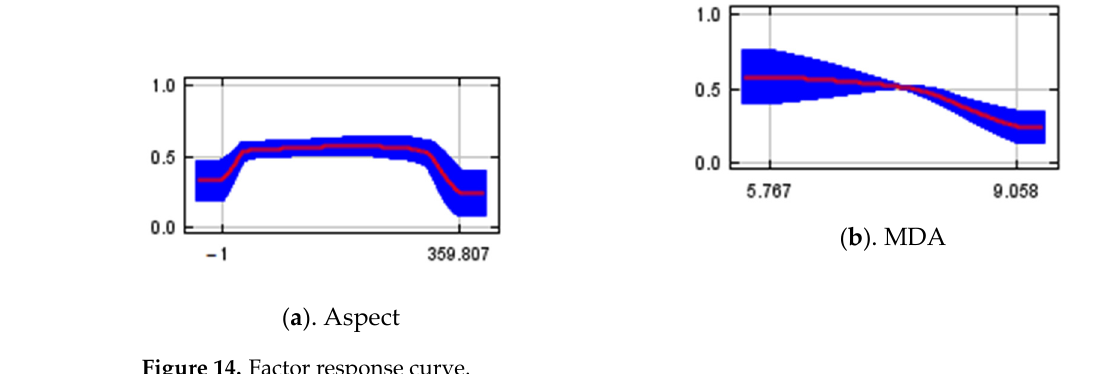
16 of 22 Figure 13. Reliability veri fi cation of CSHRR model. 4. Discussion 4.1. Model Evaluation and its Advantages The mean AUC of the potential distribution of Cryptomeria fortunei in the DTL water- shed, constructed by our MaxEnt model, was 0.832 with a standard error of 0.036. This result was greater than 0.7, indicating that the model’s output was reasonable. However, the performance of the MaxEnt model was in fl uenced by many hyperparameters, such as regularization strength, iteration number, and regularization multiplier [45]. In the next step, optimizing the parameters of the MaxEnt model can enhance the applicability of quantifying the response relationship between di ff erent factors and species. The correla- tion coe ffi cients of our CSHRR model revealed an interesting result. Due to space con- straints, we discuss Aspect and MDA as examples (Figure 14). Despite Aspect having a higher contribution to the species distribution, it showed a negative correlation (Correla- tion coe ffi cient value = − 0.035), which corresponds to the response curve of the MaxEnt